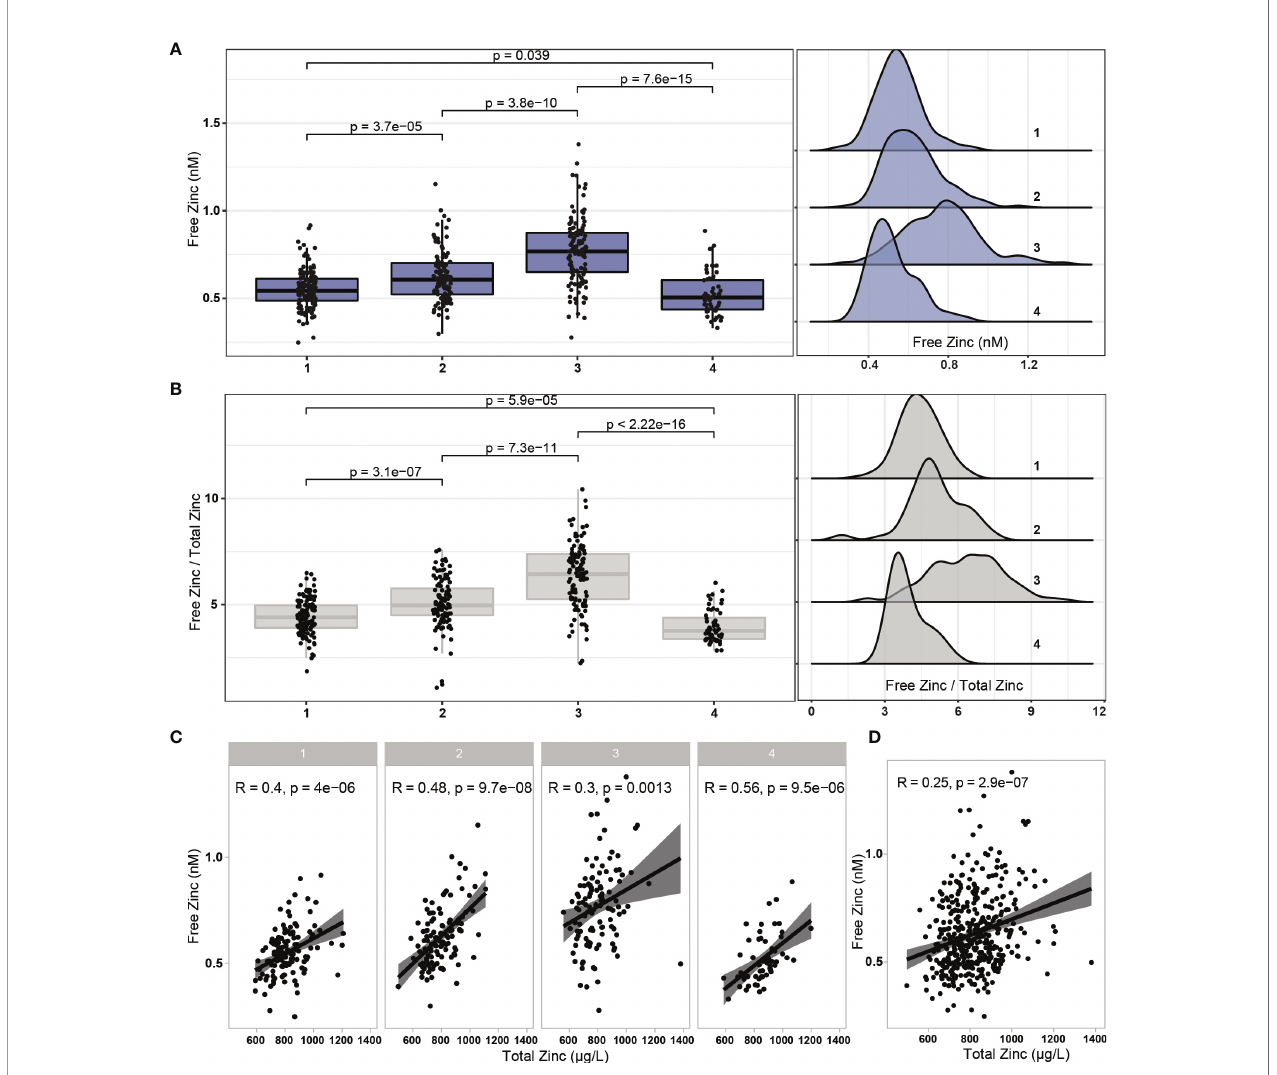
FIGURE 2 | Changes in free Zn concentrations and free Zn/total Zn ratio during the study. (A) Free Zn concentrations displayed a transient peak at time point three (six weeks after fi rst vaccination), and a relative minimum at study termination (24 weeks after fi rst vaccination). (B) The ratio of free Zn/total serum Zn showed a similar and more pronounced pattern of changes. (C) Total serum Zn and free Zn correlated positively at all sampling time points. (D) In the full cohort of samples, the parameters free Zn and total serum Zn showed a positive linear correlation. Three data points of exceptionally high serum Zn are not shown due to reasons of scale. Pairwise comparisons were conducted by applying the Wilcoxon-Rank-Sum test. Correlations were analysed by Spearman ’ s rank